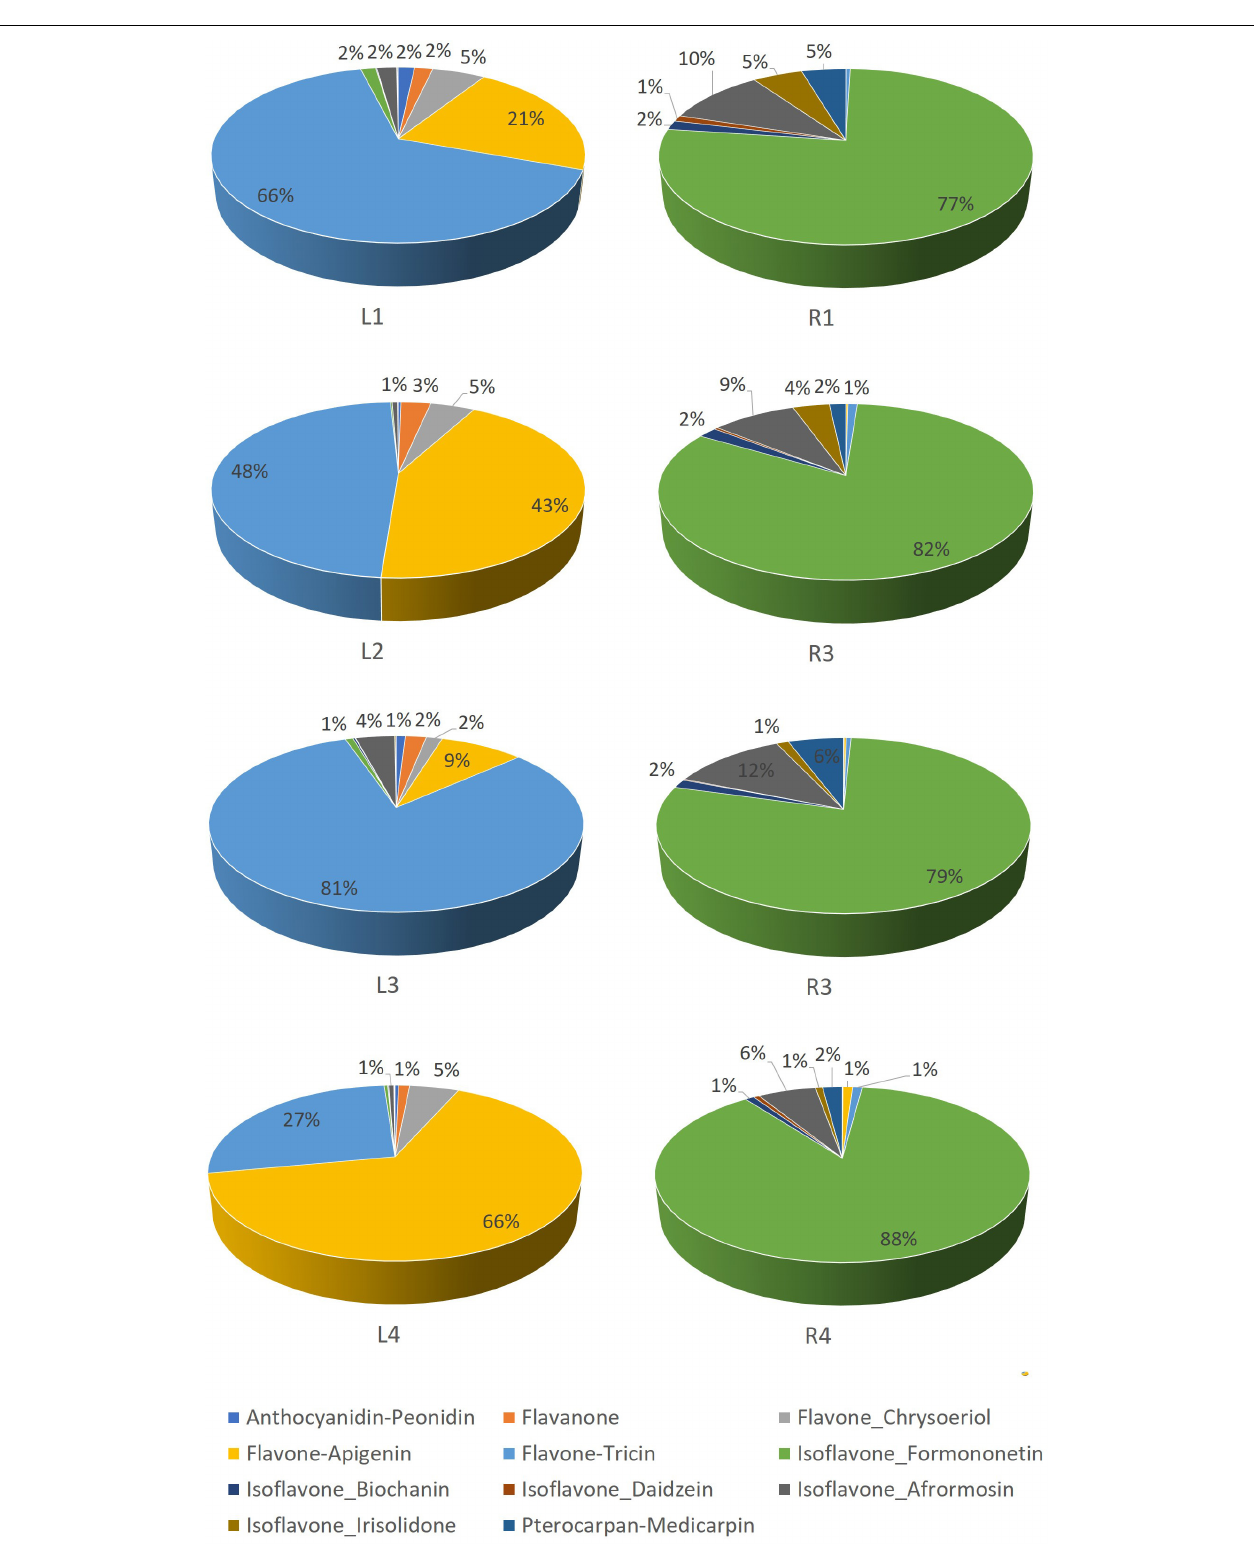
FIGURE 3 | Relative abundance (%) of flavonoid families in Medicago truncatula leaves and roots.